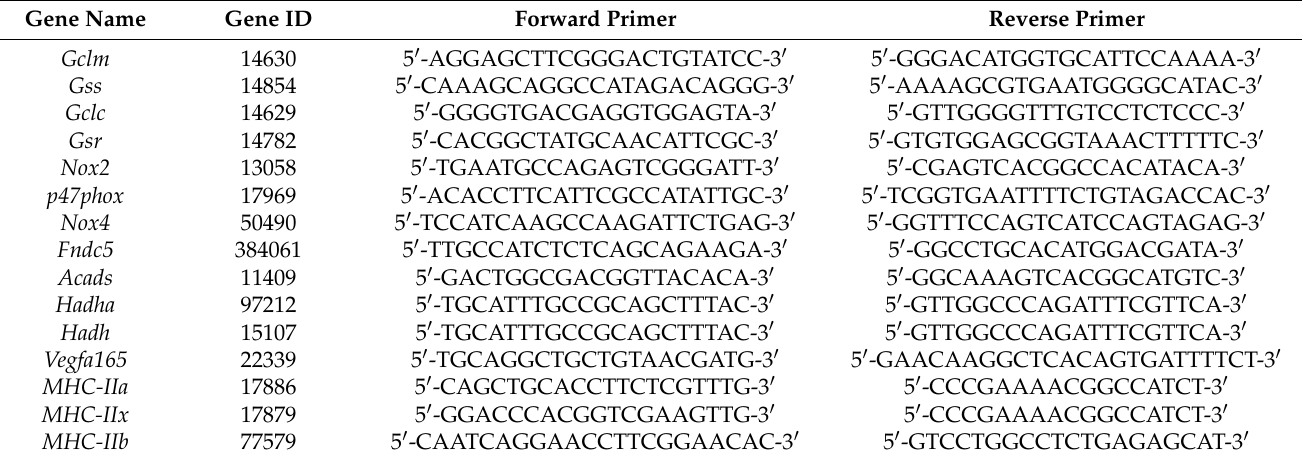
Table 1. Description of primers used for quantitative real-time